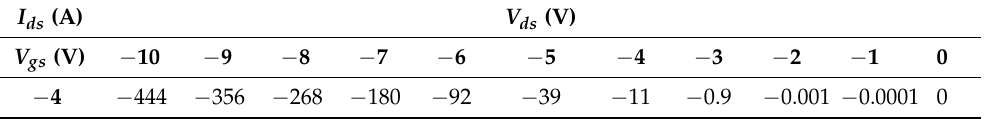
Table 1. SiC MOSFET body diode I ds current with respect to the V gs & V ds voltages at 25 ◦ C.